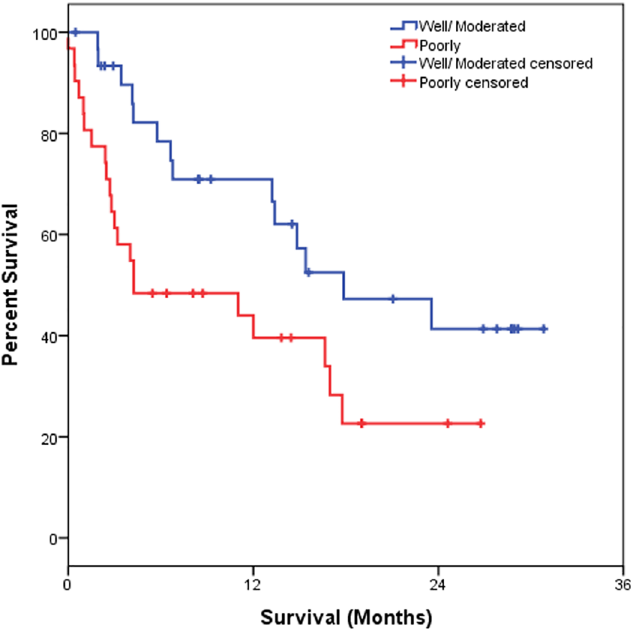
Fig 4. Kaplan-Meier survival estimatesby stratification of degree of differentiation in NSCLC patients.